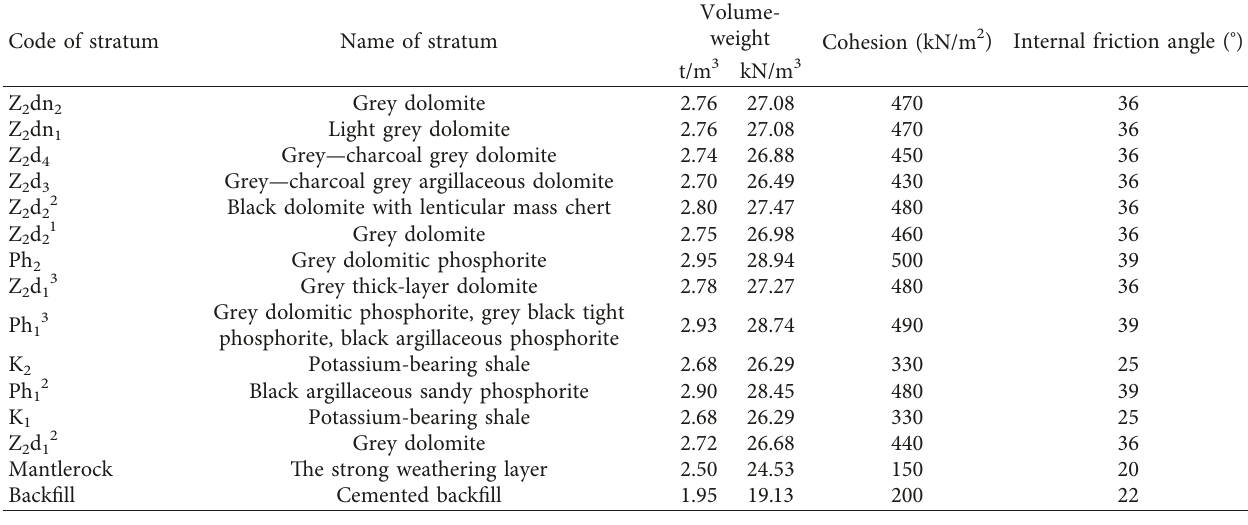
Table 4: Physical and mechanical parameters of rock (ore)